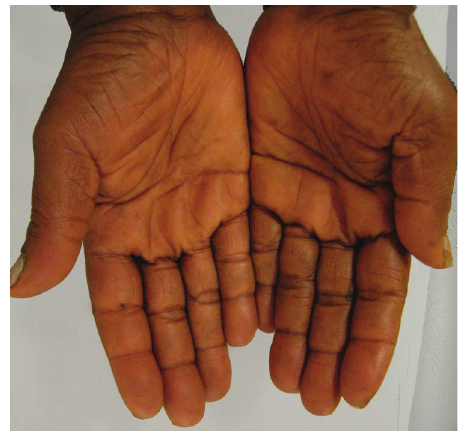
Figure 4: Complete clinical remission of palmar hyperkeratosis at 9 months of levothyroxine